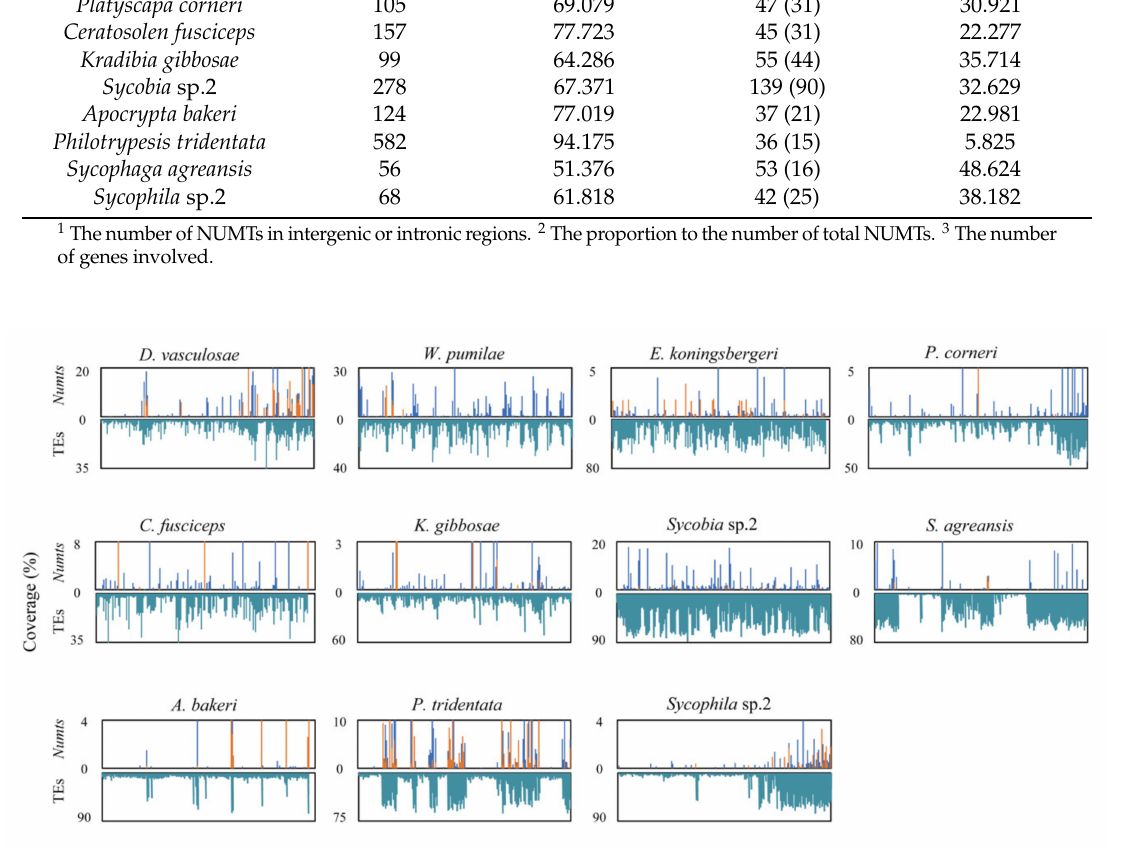
Figure 4. The density distribution of NUMTs and transposable elements (TEs) on the genome. The results of each species are shown in separate panels, with the distribution of “insertion type” (as labeled in blue color) and “duplicate type” (as labeled in orange color) NUMTs on top of the panel and that of total TEs (including DNA transposons, long interspersed nuclear elements (LINEs), short interspersed nuclear elements (SINEs), rolling cycles (RCs), and long terminal repeats (LTRs)) at bottom. The sliding window size was set to 50 kb. The horizontal axis represents position of the windows in the nuclear genome, and the vertical axis represents the coverage of NUMTs or TEs in the sliding